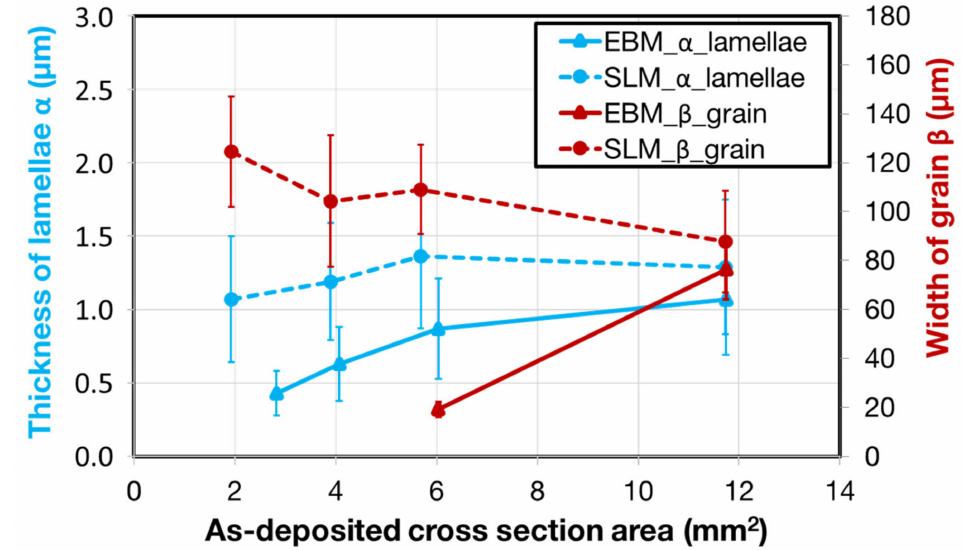
Figure 11. Summary of microstructure scale and its dependence on as-deposited cross section area. SLM data summarized from previous